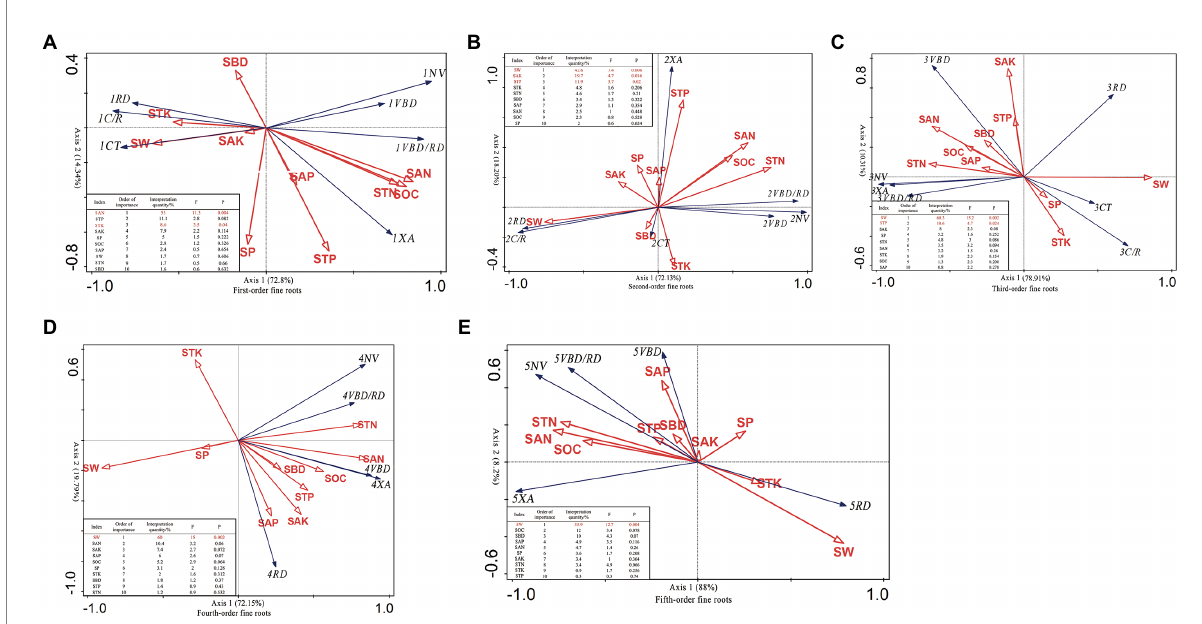
FIGURE 2 RDA analysis between soil environmental factors and fine root anatomical structure of C. funebris . First-order fine roots (A) , second-order fine roots (B) , third-order fine roots (C) , fourth-order fine roots (D) , fifth-order fine roots (E) . The blue arrows represent the anatomical features of fine roots, including (RD, VBD, VBD/RD, CT, C/R, XA, NV); Red arrows represent the cedar wood and soil environmental factors, including (SOC, STN, STP, SAN, SAK, SAP and SAK, SW, SBD, SP). RD, means fine root diameter, VBD, means vascular bundle diameter, VBD/RD, means stele: root diameter ratio, CT, means cortex thickness, C/R, means cortex ratio, XA, means xylem area, NV, means number of vessels; SOC, means organic carbon, STN, means Total nitrogen, STP, stands for total phosphorus, STK, stands for total potassium, SAN, stands for alkali hydrolyzed nitrogen, SAP, stands for available phosphorus, SAK, stands for available potassium; SW, stands for soil moisture, SBD, stands for soil bulk density, and SP, stands for soil porosity. The letters in this figure indicated the same meaning as the chart